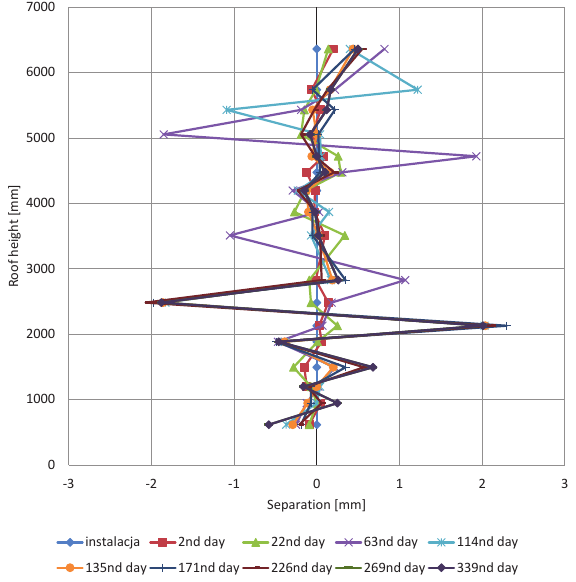
Fig. 7. Roof separation of S bypass of Ilz shaft Figure 7: Roof separation of S bypass of Ilz shaft.